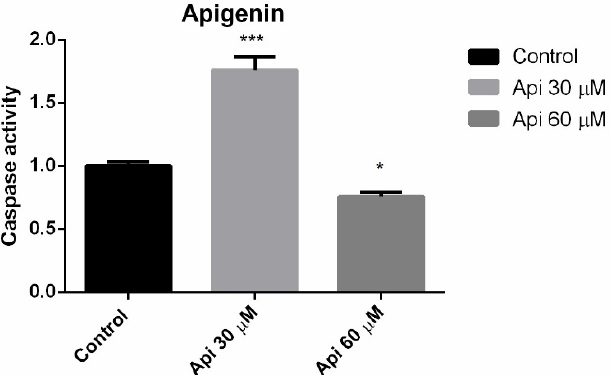
Figure 4. Caspase 3 activity in A375 human melanoma cells after 72 h of incubation with Api. * p < 0.05; *** p < 0.001.